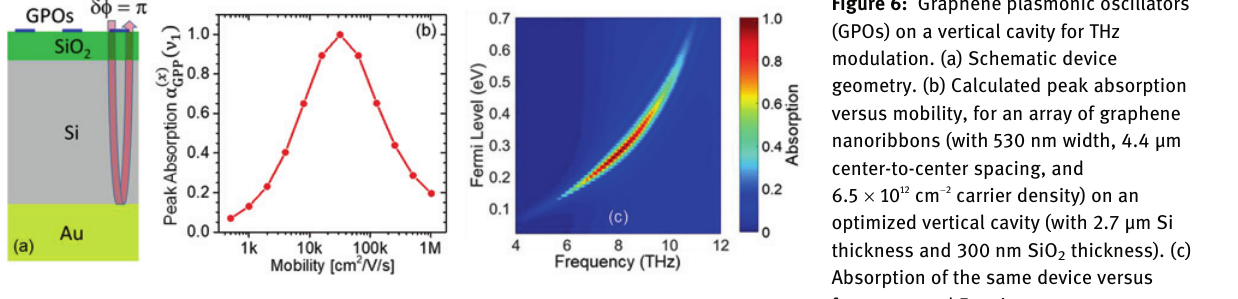
Figure 6: Graphene plasmonic oscillators (GPOs) on a vertical cavity for THz